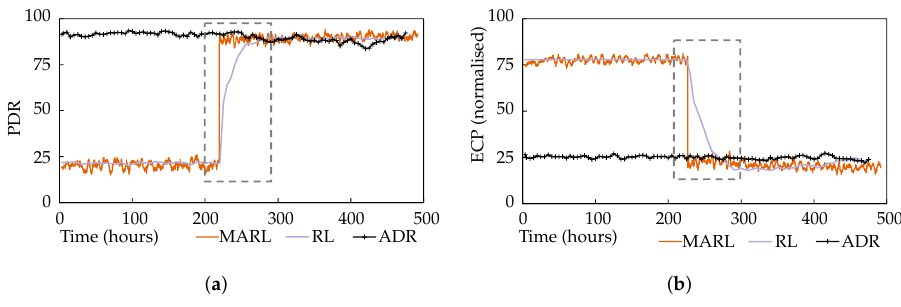
Figure 6. Scenario 1 results: ( a ) PDR performance for scenario 1. ( b ) ECP performance for scenario